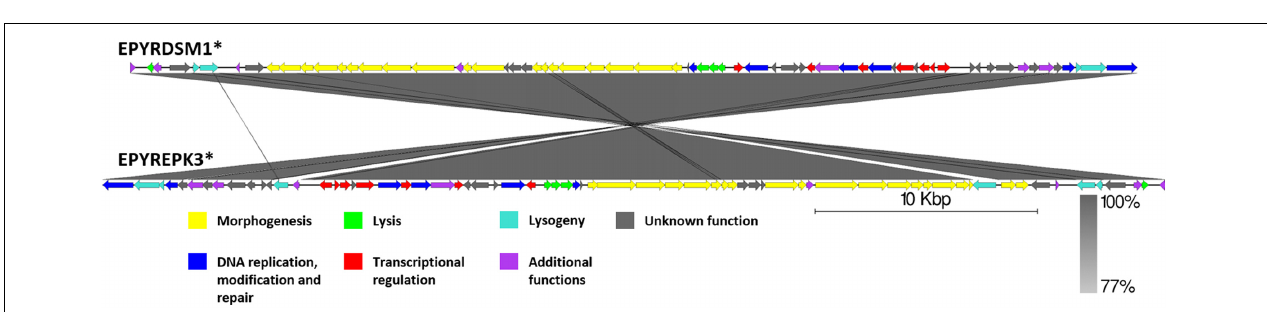
FIGURE 8 | Pairwise genome nucleotide sequence comparison of putative prophage regions from the suggested cluster 4, subcluster 4.1. Genomes are linearized and drawn to scale; scale bar indicates 10 thousand base pairs. Arrows representing open reading frames point in the direction of transcription and are color-coded according to the legend. Gray boxes between genomes represent regions of similarity and are gradient-colored according to their identity; darker shade of gray represents higher identity. The asterisk next to the phage name indicates a prophage derived from chromosome of Erwinia sp.